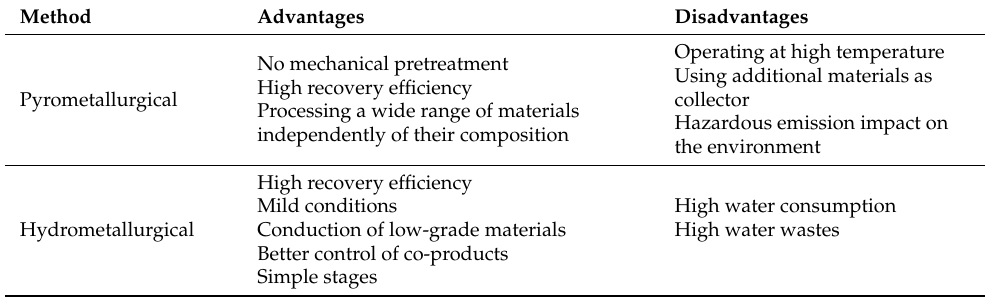
Table 3. Comparison between pyrometallurgical and hydrometallurgical recycling process